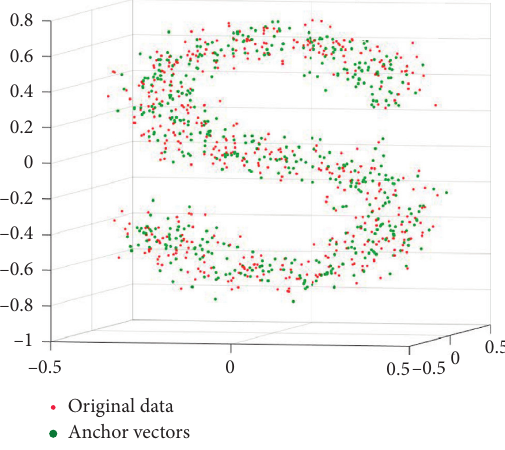
Figure 10: The set of anchor vector.